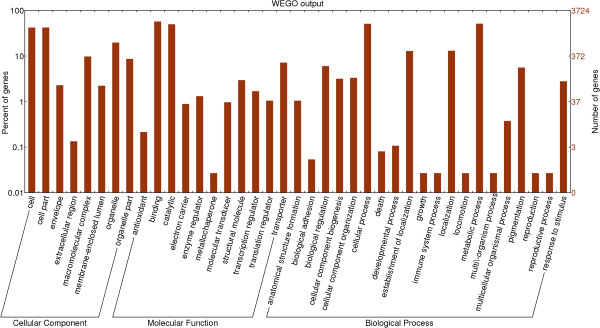
Gene ontology (GO) classification of the Metschnikowia fructicola unigenes. Out of 9674 unigenes, 4126 sequences were annotated within GO database into three main categories: cellular component, biological process, molecular function and. Y-axis indicate the number of unigenes while the x-axis indicate the GO category.